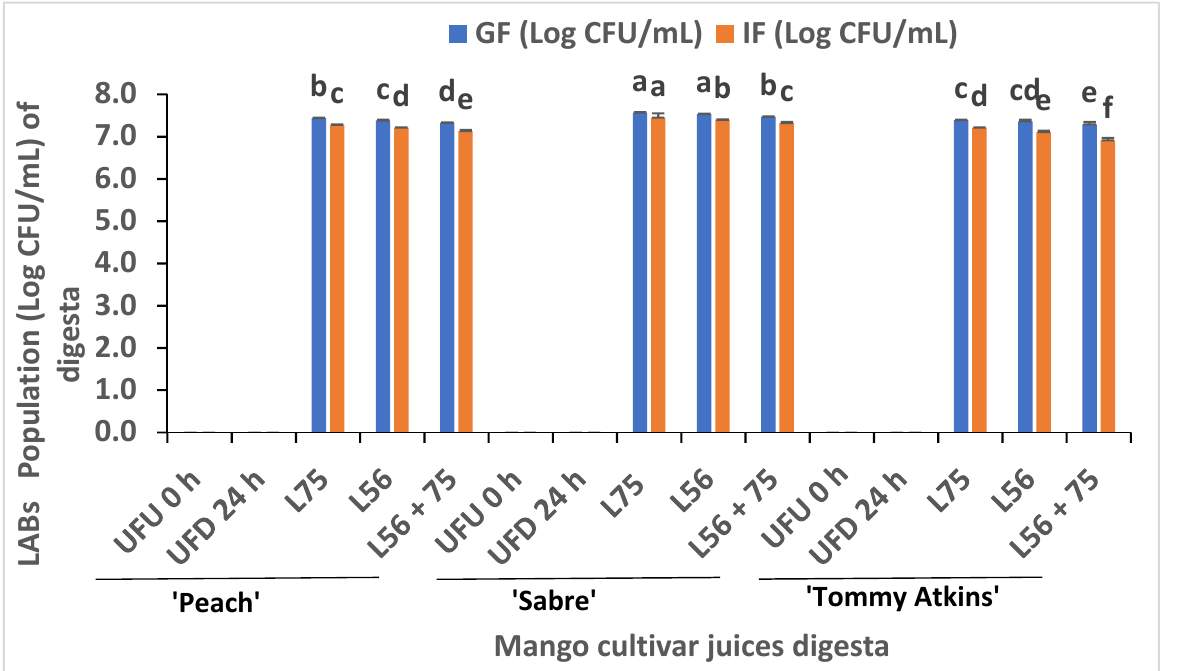
Figure 2. Survival of LAB from fermented MJs of three different cultivars during in vitro GI digestion. Similar colored bars with the same alphabetic letter are not significantly different ( p ≤ 0.05). Keys: UFU 0 h—raw unfermented and undigested MJs (control); UFD 24 h—unfermented digested MJs stored for 24 h; Ltp. plantarum (L75); Leu. pseudomesenteroides (L56); Leu. pseudomesenteroides 56 + Ltp. plantarum 75 (L56 + 75); gastric fraction (GF); Intestinal fraction (IF), Log CFU/mL = Logarithmic colony forming unit per milliliter of digested fractions.